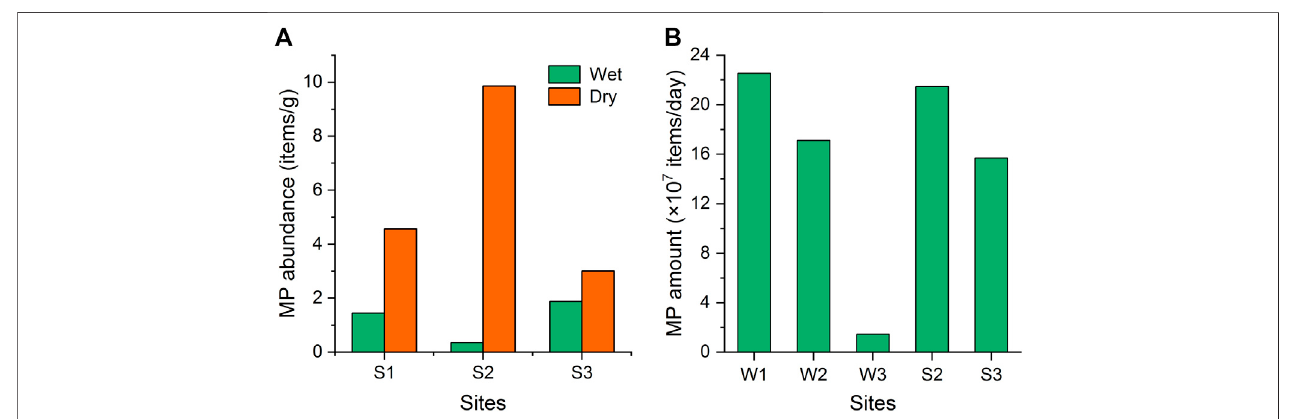
FIGURE 3 | MP abundance in sludge (A) and MP balance analysis of Haicang WWTP (B) in 2018.